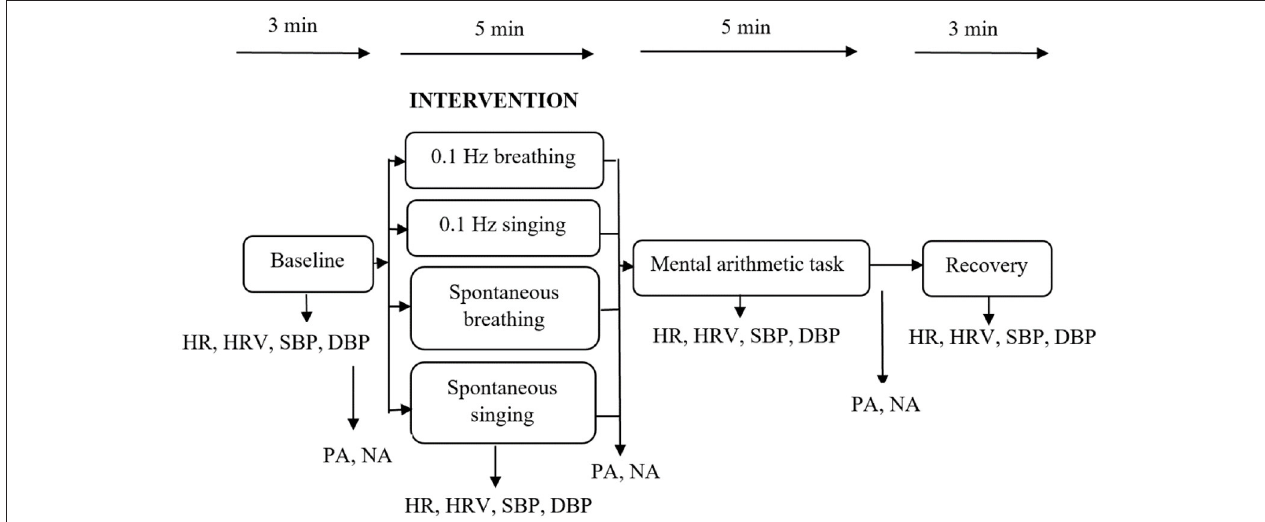
FIGURE 2 | Study procedure and main variables. HR, heart rate; HRV, heart rate variability; SBP, systolic blood pressure; DBP, diastolic blood pressure; PA, positive affect; NA, negative affect.